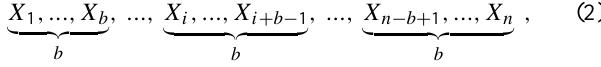
Fig. 2. Actual coverage probabilities of 90% subsampling CIs with β = 0 . 50 (black)) and β = 0 . 42 (red)) for the skewness of nonlinear time series (4) at a = 0 . 145 and n = 2048 . Horizontal green lines denote 0.85 and 0.89 levels. Table 1. Parameters of the model time series X t (Eq. (4)) distribu- tion vs sample characteristics of the observed series W t in Fig.1.